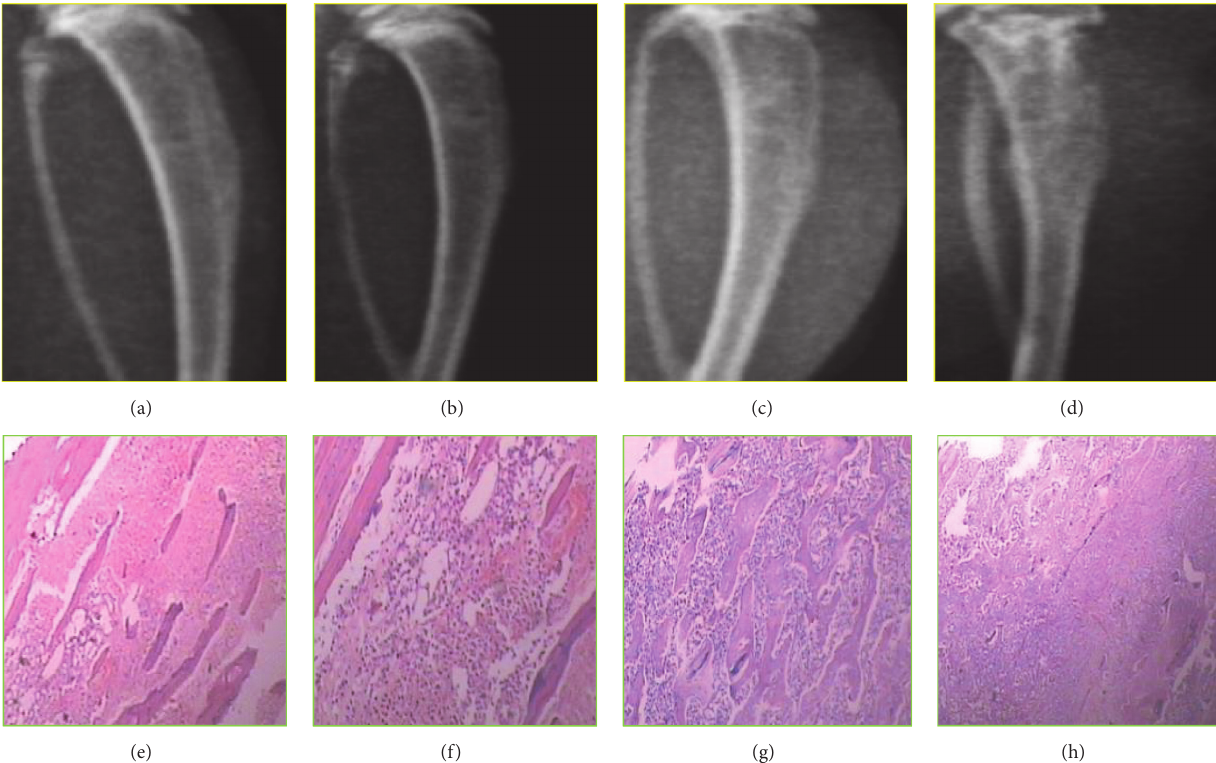
Figure 4: The development of Walker 256 cell-bearing tibias on the ipsilateral side in rats was shown radiologically (a–d) and by immunohistochemistry (e–h). (a) The normal structure of the rat tibia. (b) The evident periosteal reaction was detected 7 d after cancer cell inoculation. (c) Some loss of medullary bone and the erosion of cortical bone were observed 14d after injection. (d) Significant cortical bone defects were observed 21d after cancer cell inoculation. Accordingly, hematoxylin and eosin (HE) staining of the tumor area in the rat ipsilateral tibia on different days after operation is shown (e–h). Scale: 50 mm, 𝑛 = 6